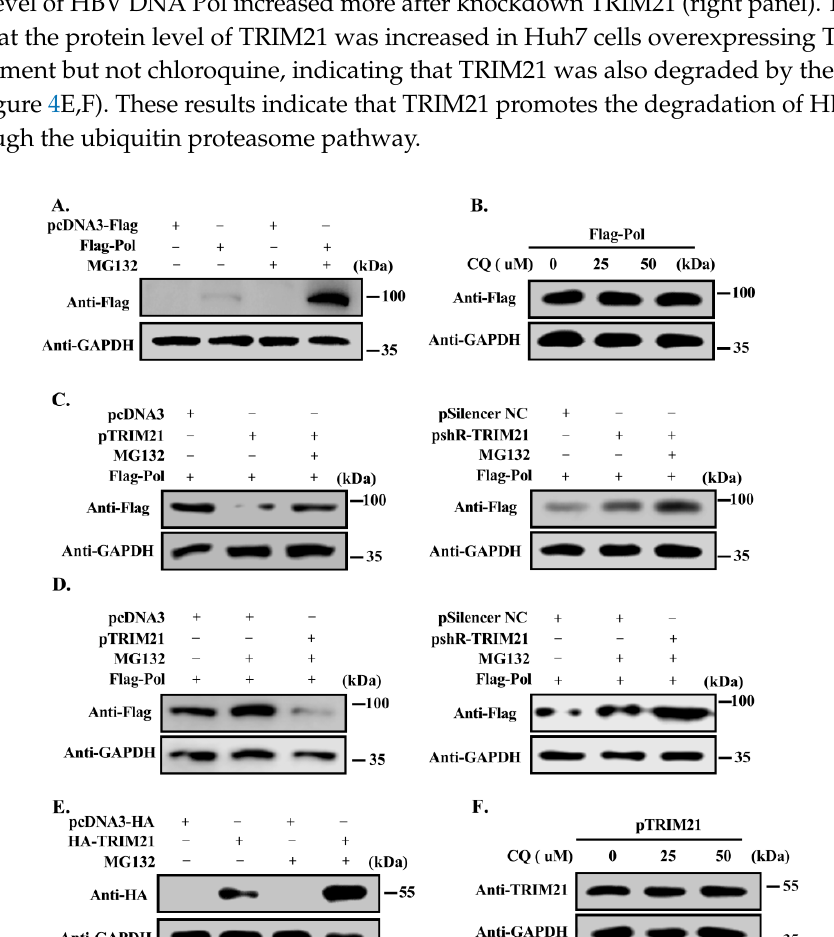
Figure 4. TRIM21 promotes the degradation of HBV DNA Pol through the ubiquitin proteasome pathway via its RING domain. ( A ) Huh7 cells were transfected with FLAG-HBV DNA Pol expression plasmid. After 30 h, the cells were treated with 20 μ M MG132 for 8 h, and Western blot was used to detect the protein level of HBV DNA Pol. ( B ) The cells were transfected as described in ( A ) except for using 0, 25 or 50 μ M chloroquine to treat the cells for 6h. ( C ) FLAG-HBV DNA Pol was cotransfected with pcDNA3/pTRIM21 (left panel) or pSilencer-NC/shR-TRIM21 (right panel) in Huh7 cells, and MG132 treatment conditions were the same as in ( A ). Then, Western blot was used to detect the protein level of HBV DNA Pol. ( D ) Huh7 cells were cotransfected with FLAG-HBV DNA Pol and pcDNA3 (left panel)/pSilencer-NC (right panel) and treated with MG132 as described in ( A ), or cotransfected with pTRIM21 (left panel)/shR-TRIM21 (right panel). The protein level of HBV DNA Pol was analyzed by Western blot. ( E ) Huh7 cells were transfected with TRIM21 overexpression plasmid, and MG132 treatment was the same as in ( A ). Then, Western blot was used to detect the protein level of TRIM21. ( F ) The same as in ( B ), except for using chloroquine, and the cells were transfected as described in ( E ). ( G ) Huh7 cells were cotransfected with FLAG-HBV DNA Pol and pcDNA3 or HA-TRIM21, and the cells were treated with 10 μ M MG132. Subsequently,